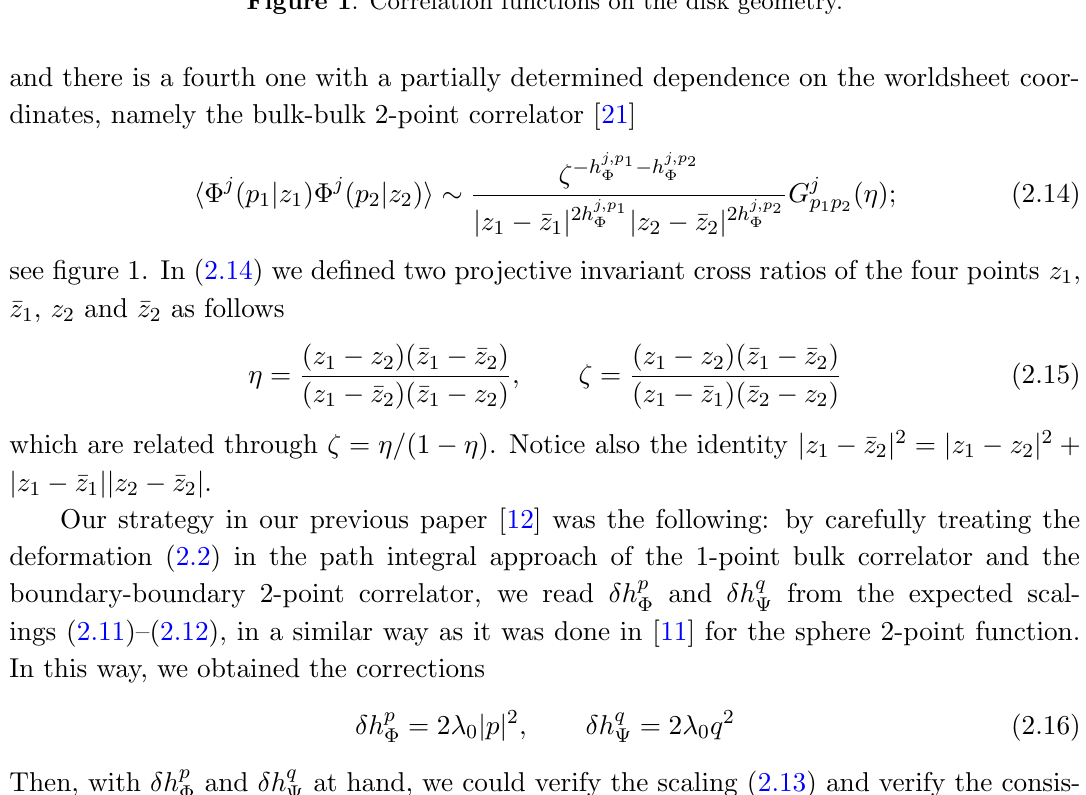
Figure 1 . Correlation functions on the disk